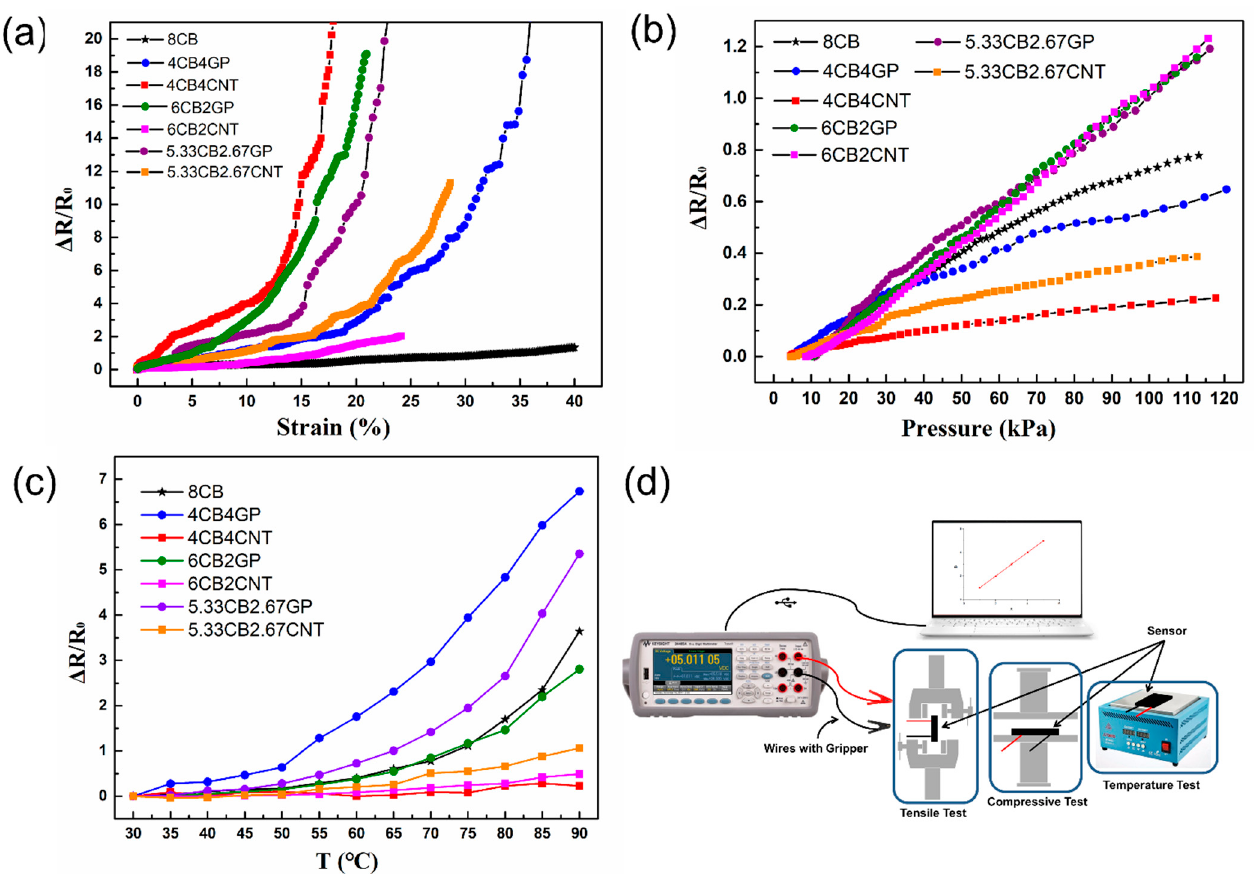
Figure 4. The test results and schematic of the test devices, showing the relative resistance changes in the conductive rubber composite stretchable tactile sensors with various material mass ratios as a function of strain ( a ) and pressure ( b ), and ( c ) relative changes in the resistance of the stretchable tactile sensors as a function of temperature, and ( d ) schematic of the test devices.